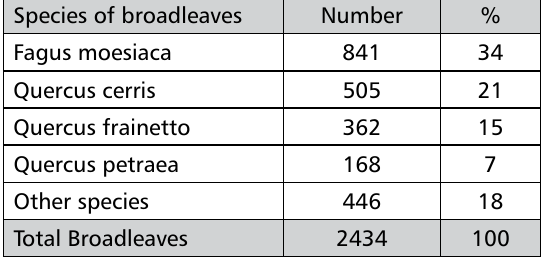
Percentage of broadleaved trees on sample plots in